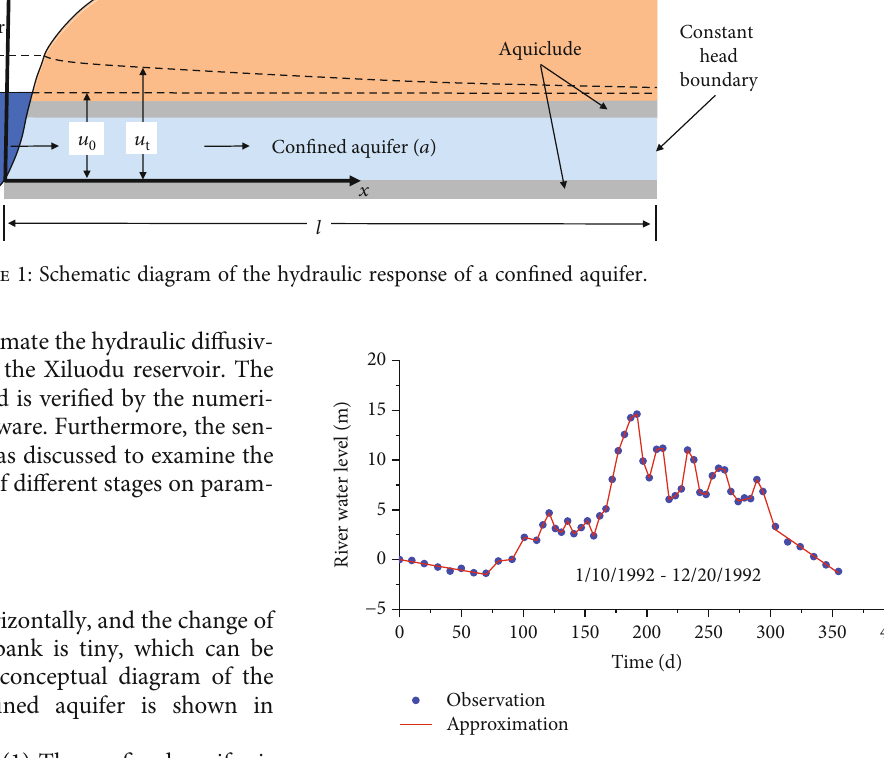
Figure 2: Linearization of reservoir water